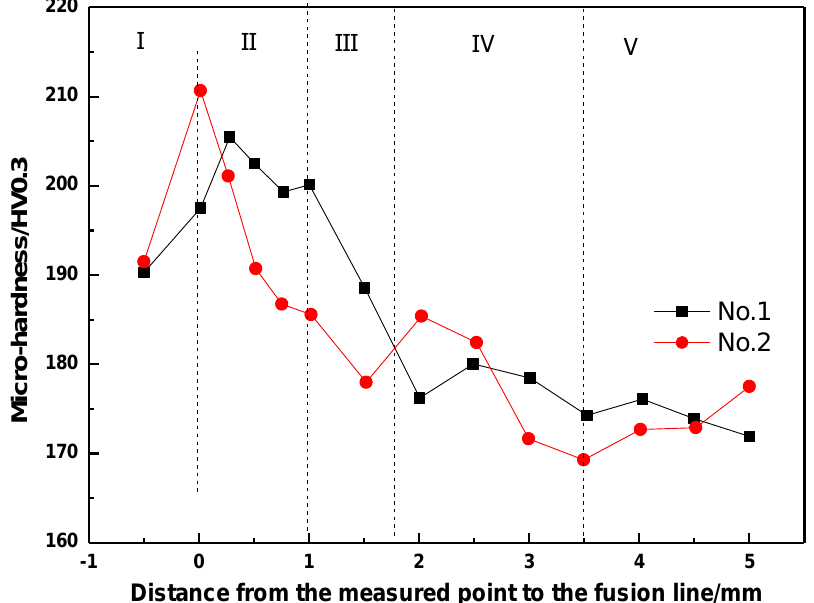
Figure 10. Micro − hardness variation from welding line to base metal for the two steels. The five regions (I–V) in the figure are weld line (I), fusion and CGHAZ (II), FGHAZ (III), ICHAZ (IV), and base metal (V).